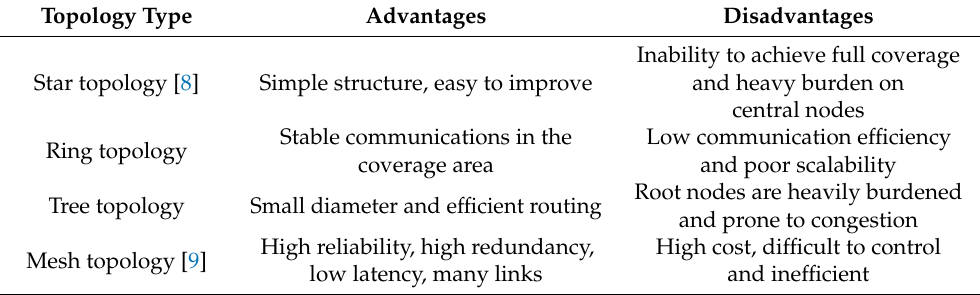
Table 1. Topology